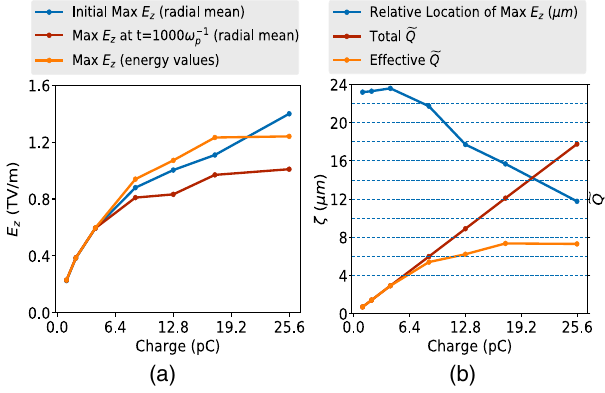
FIG. 10. The variations of initial, final and average maximum axial longitudinal electric fields with charge are plotted in (a). Beam is partially bunched ( B ¼ 0 . 71 ) and the current ratio between the peak and flat region ≈ 20 . Emittance is scaled linearly with charge ( 3 . 2 pC → 50 nm rad). The location of the peak longitudinal electric field, total and effective normalized ˜ Q charge density are plotted in part (b). The dashed lines correspond to the positions of the bunches.